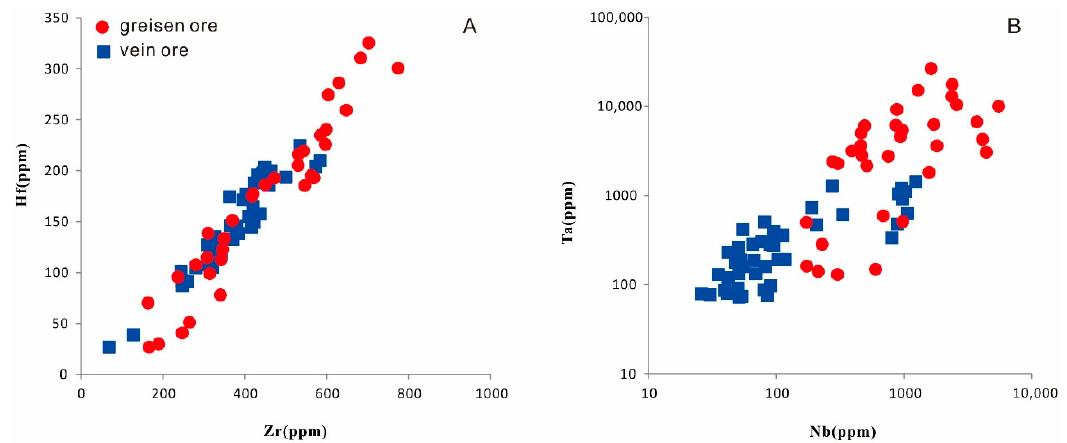
Figure 10. Selected scatterplots of trace elements in the cassiterite samples.